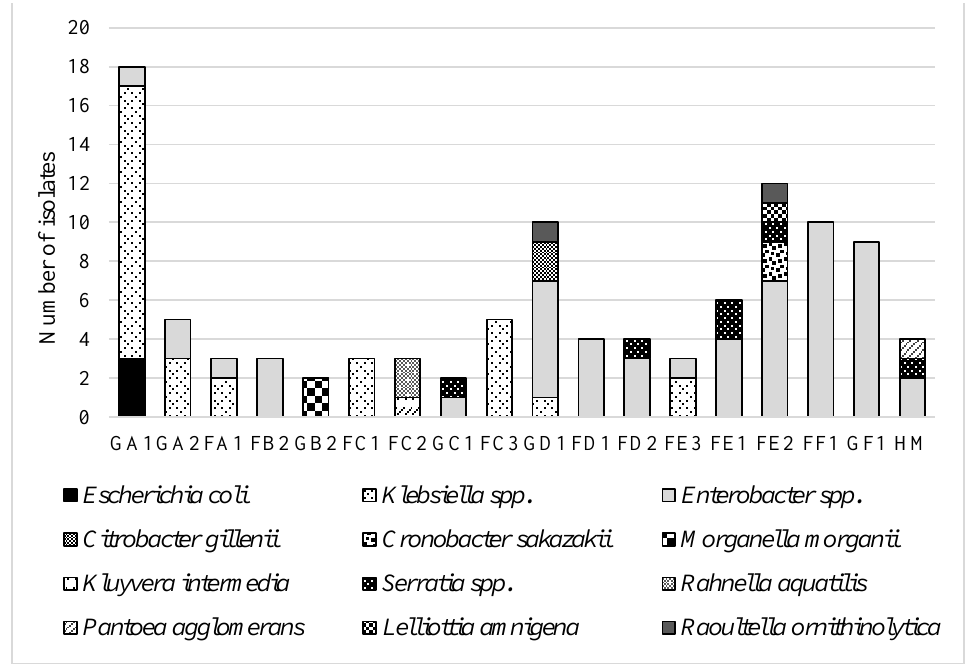
Figure 1. Identified antibiotic-resistant coliform bacteria in smoothies collected from fresh bars in Bratislava.